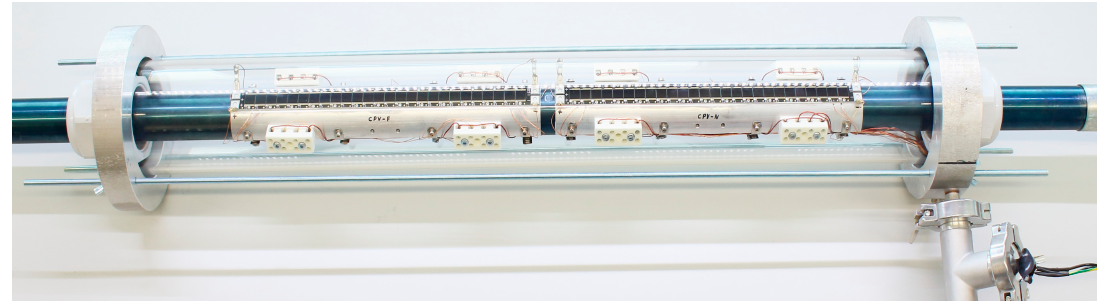
Figure 21. Next-generation CPV-T hybrid absorber designed based on the results of this presented research. This design is currently undergoing field testing.